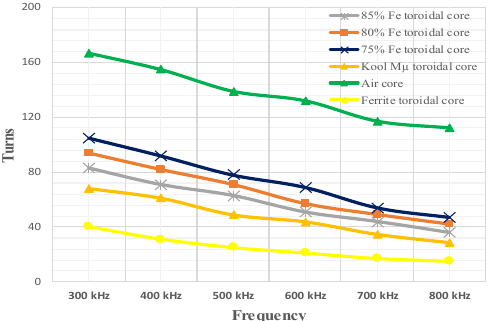
Figure 25. Number of turns in each core for the required inductance.